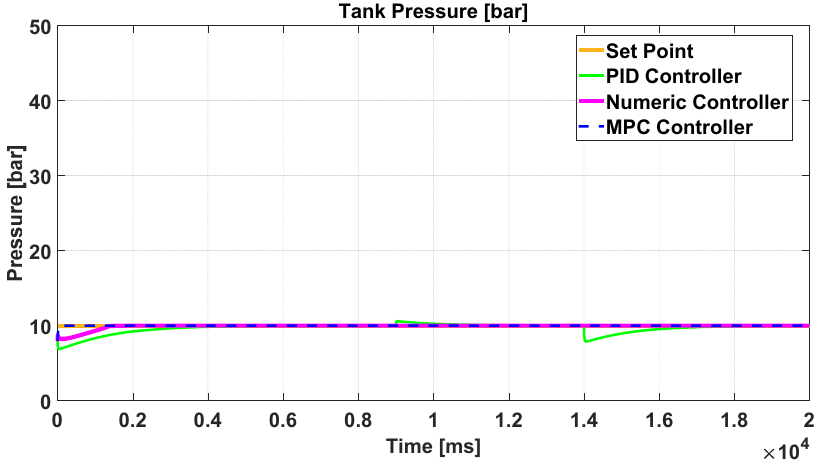
Figure 15. Performance of control algorithms in relation to the pressure variable.